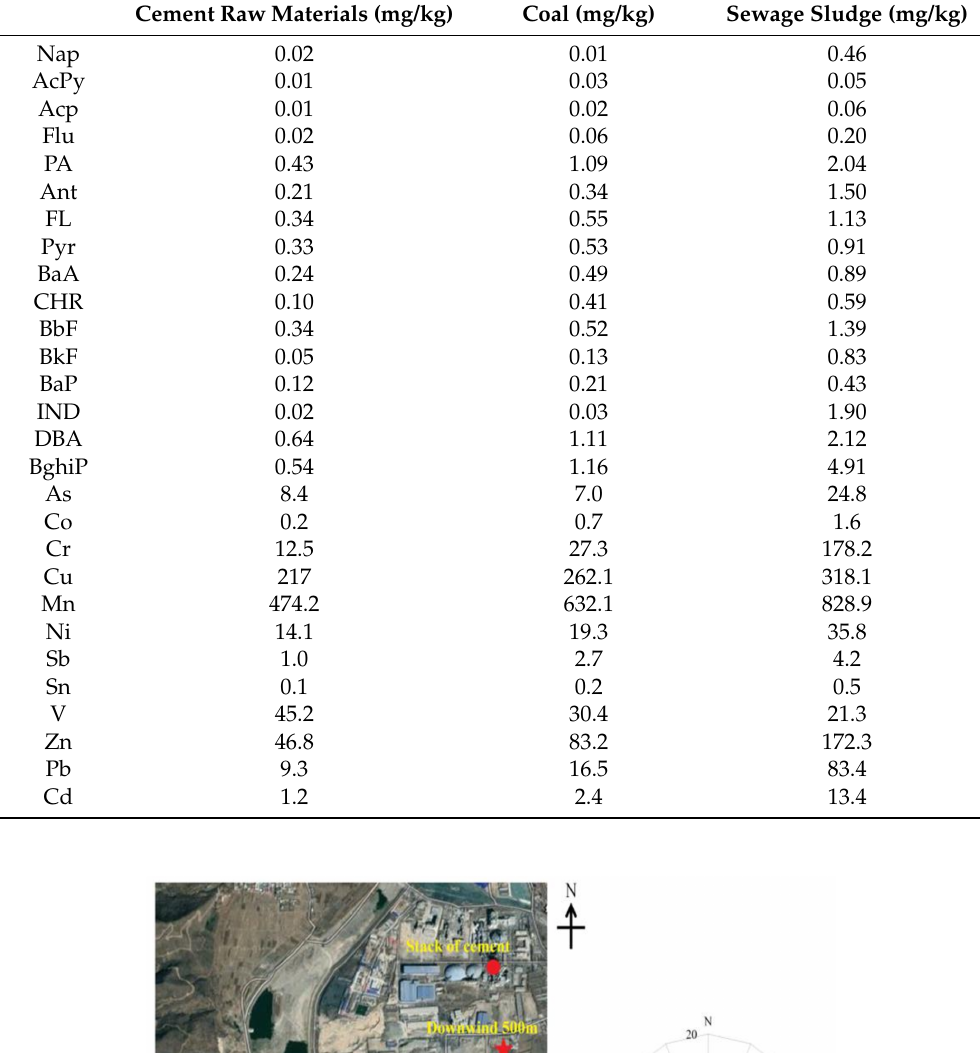
Table 1. Polycyclic aromatic hydrocarbons and heavy metals concentrations in raw materials, fuels and sewage sludge.